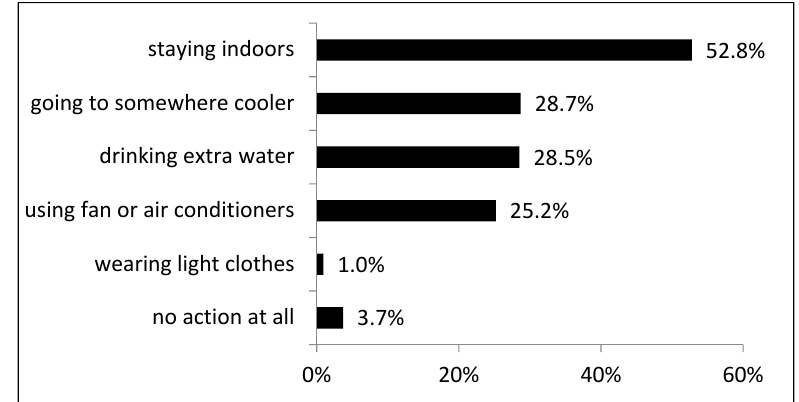
Figure 1. Choices of participants’ coping behavior during hot weather.